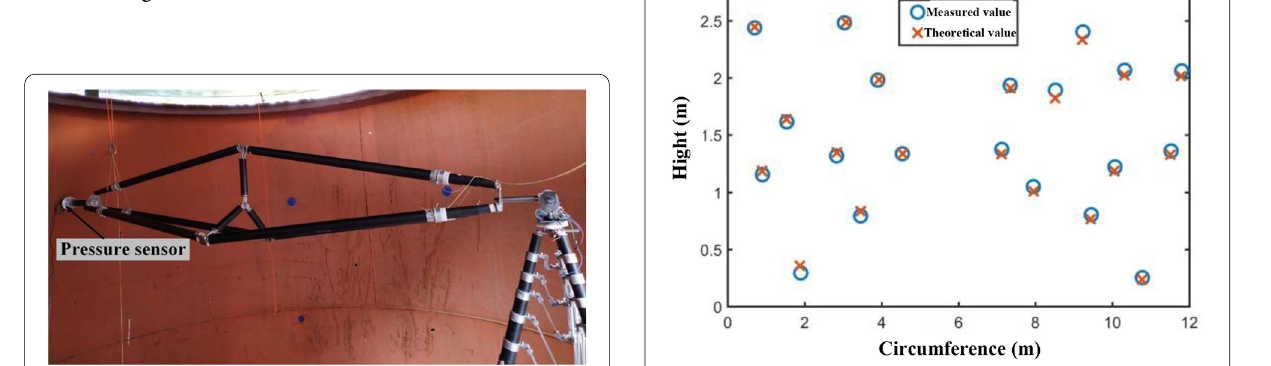
Figure 15 Support capability testing